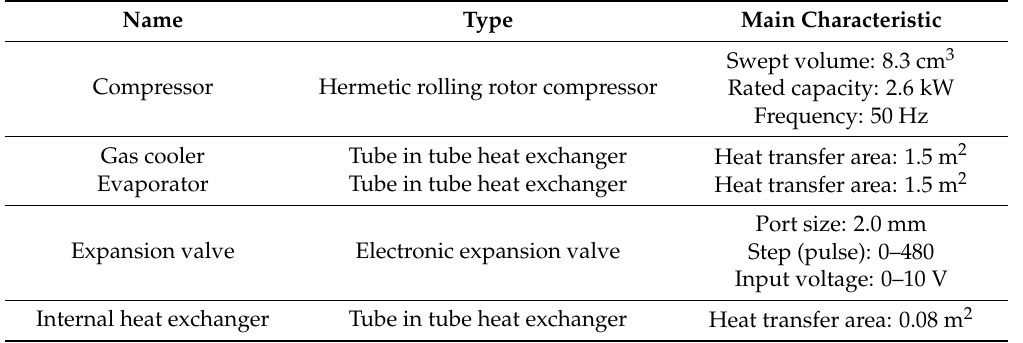
Table 1. Main components of the